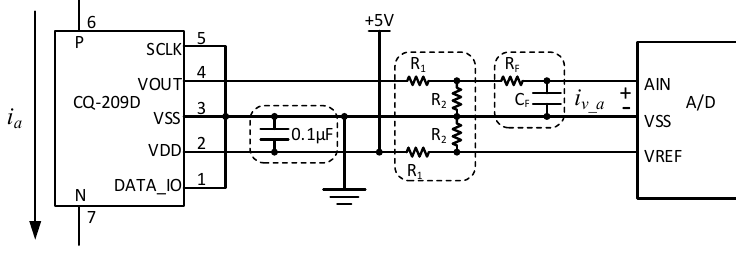
Figure 6. Current sensor design for TMS320F28335-based NN controller